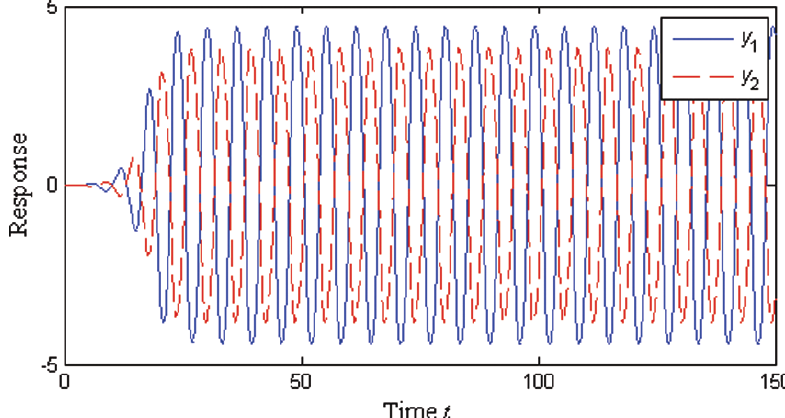
Fig. 12. Time history with feedback control, β 11 = β 12 = β 21 = β 22 = 5.